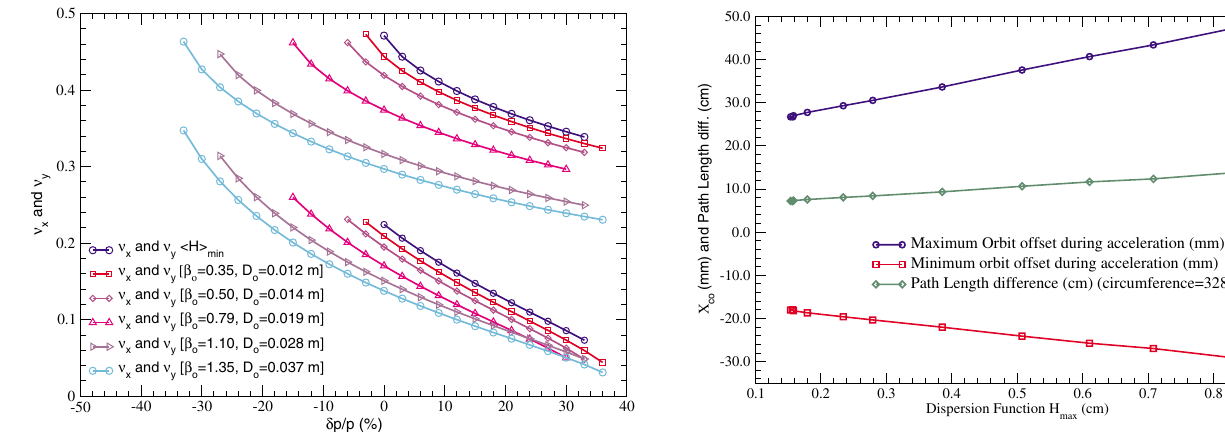
FIG. 7. (Color) Dependence of horizontal and vertical betatron tunes on momentum for various initial conditions for (cid:5) D . The starting point is the condition for the minimum of the x 0 h H i function with initial value of the amplitude and dispersion (cid:1) 0 : 186 m D (cid:1) 0 : 008 . Relations between and functions (cid:5) 0 0 stable regions for the tunes are